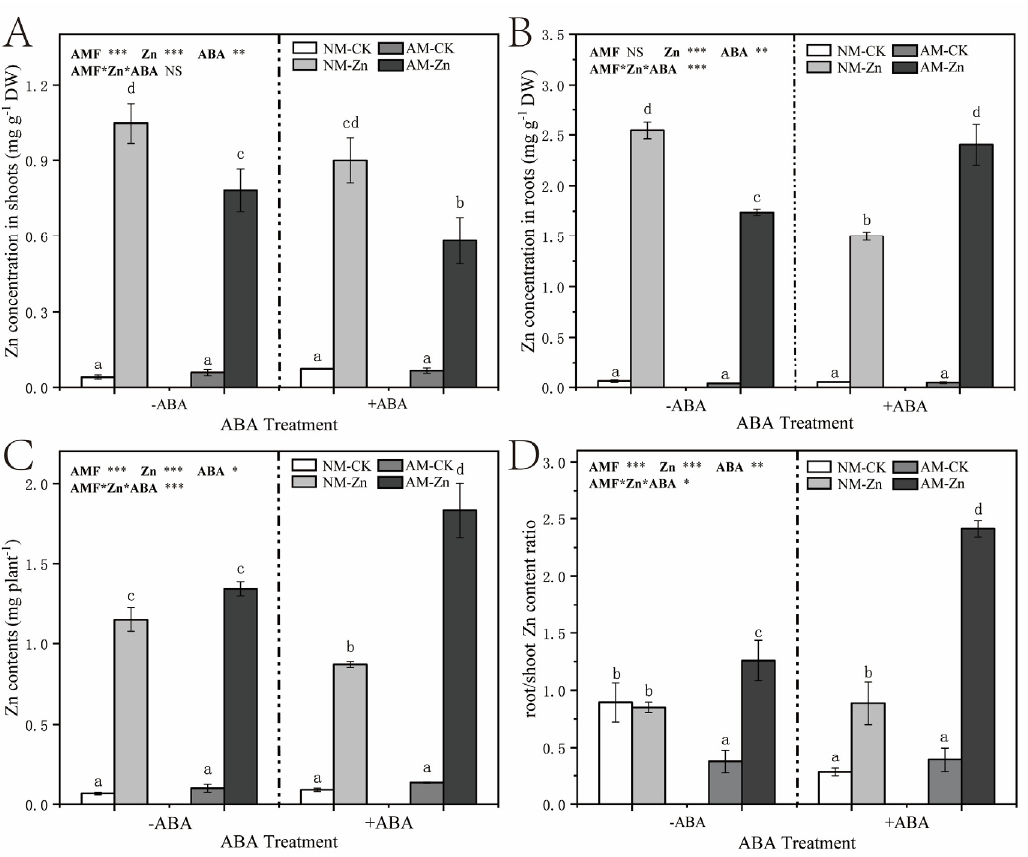
Figure 2. ( A , B ) Zn concentration in the shoots and roots of black locust plants; ( C ) Total Zn contents in plants; ( D ) root/shoot Zn content ratio of black locust plants. The data show the means ± standard deviations ( n = 3). The different letters above the bars indicate significant differences among the means of the Zn concentration in the shoots, the Zn concentration in the roots, the total Zn content or the ratio of root/shoot and Zn content ratio according to Tukey’s test ( p < 0.05). *, p < 0.05; **, p < 0.01; ***, p < 0.001; NS, not significant. The abbreviations used are the same as those used above.